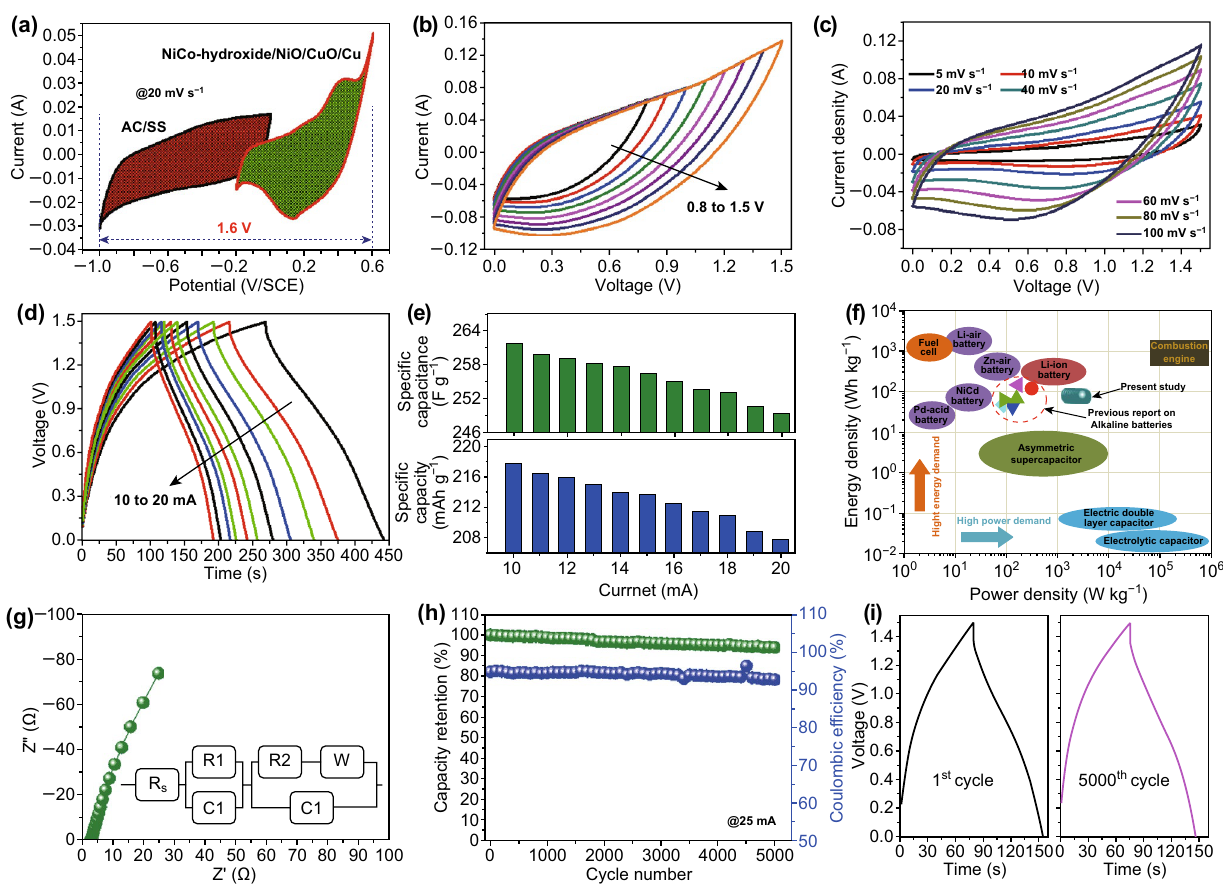
Fig. 4 CV curves for a the AC/SS and NiCo‑hydroxide/NiO/CuO/Cu electrode in 2 KOH electrolyte at a constant scan rate of 20 mV s −1 , b the NiCo‑hydroxide/NiO/CuO/Cu//AC/SS RAB at various applied voltage ranges, and c the NiCo‑hydroxide/NiO/CuO/Cu//AC/SS RAB at vari‑ ous scan rates in the voltage window of 0–1.5 V. d CD curves for the NiCo‑hydroxide/NiO/CuO/Cu//AC/SS RAB at various currents. e Plot of specific capacitance and specific capacity at various discharge current for the NiCo‑hydroxide/NiO/CuO/Cu//AC/SS RAB. f Ragone plot for the NiCo‑hydroxide/NiO/CuO/Cu//AC/SS RAB. g Nyquist plot for the NiCo‑hydroxide/NiO/CuO/Cu//AC/SS RAB; the inset shows the fitted